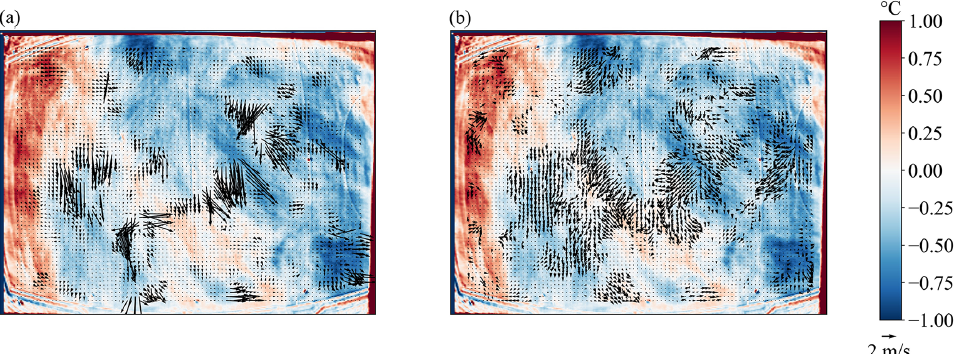
Figure 6. Error vector removal due to correct correlation time interval setting – (a) a TURF-T1 TIV with a correlation time interval of 0.5s. (b) The same TIV with an interval setting of 1.5s, which was calculated using the HHT. The large error vectors mask the display of the small-scale vectors within panel (a)